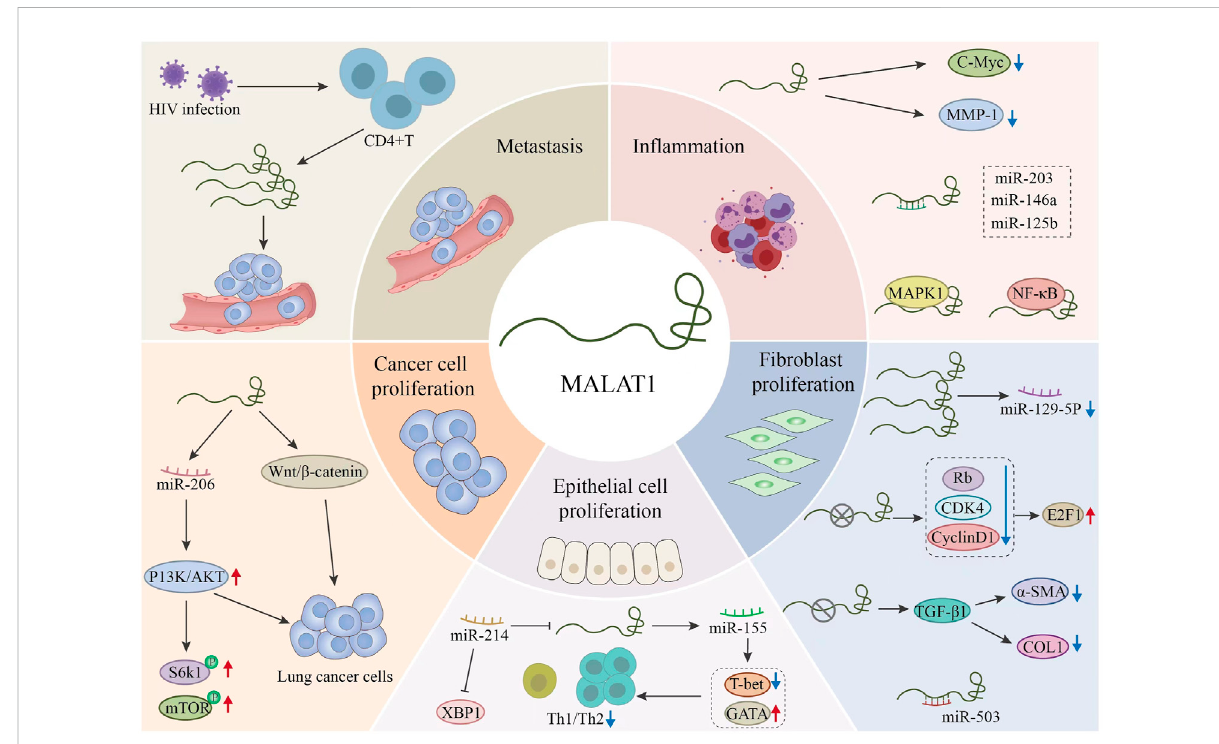
FIGURE 4 Regulation of different microRNAs (miRNAs) by MALAT1 and the related targets of action of MALAT1.This fi gure explains the pathophysiology related aspects in the process of related respiratory diseases through MALAT1. MALAT1 further affects the development of the disease by regulating related signal pathways, proteins and